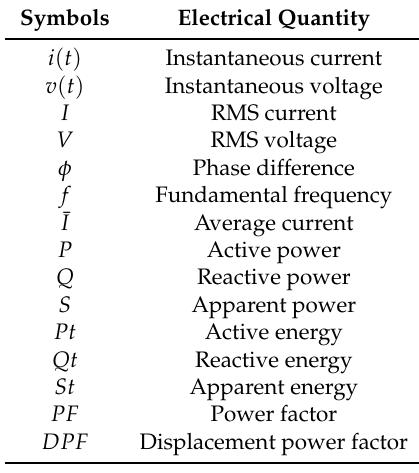
Table 1. Electrical quantities